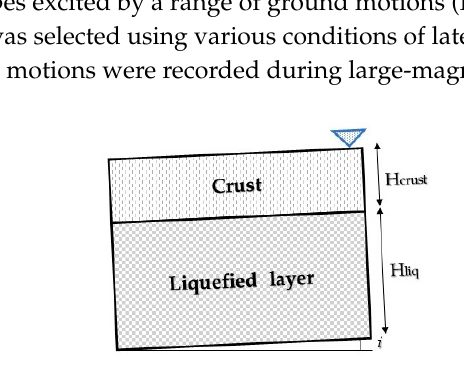
Figure 20. Idealized soil profile used in the parametric study.